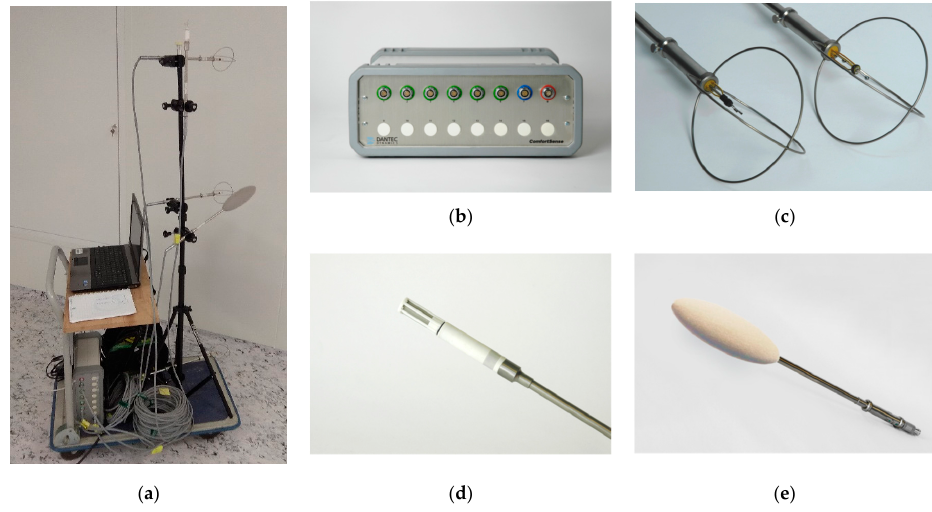
coat without long sleeves. According to the parameters of protective clothing, the actual thermal resistance of operating room workers was 0.6 CLO, which is 0.093 m 2 K/W. Ther- mal resistance was evaluated in a similar range by Bogdan et al. [39] The e ff ect of the Figure 7. ComfortSense measuring device, ( a ) device during measurement, ( b ) measuring unit, ( c ) Figure 7. ComfortSense measuring device, ( a ) device during measurement, ( b ) measuring unit, thermal resistance of protective clothing on the assessment of thermal comfort of measuring elements H1–H3, ( d ) measuring element RH, ( e ) measuring element OT. healthcare workers was also addressed in a study by Wang et al. [34]. ( c ) measuring elements H1–H3, ( d ) measuring element RH, ( e ) measuring element OT.